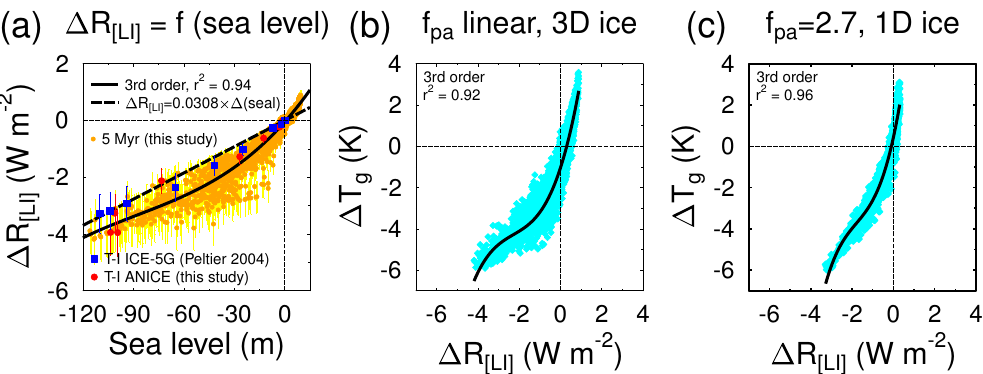
Figure 6. Details on land ice albedo forcing ( (cid:49)R [LI] ). Panel (a) : scatter plot of sea level change (de Boer et al., 2014) against land ice albedo forcing (this study), (cid:49)R [LI] , based on the 3-D ice-sheet model ANICE. Data are approximated with a third-order non-linear fit. For comparison, a fit based on sea level change as applied in other applications (Hansen et al., 2008; Martínez-Botí et al., 2015) is shown as dashed line. Furthermore, for Termination I (T-I), results based on ANICE and on ICE-5G (Peltier, 2004) are compared. Panels (b,c) : relationship between global surface temperature change, (cid:49)T g , and land ice albedo forcing, (cid:49)R [LI] , for different set-ups. Results plotted over the whole last 5Myr (one data point every 2kyr). Panel (b) : standard set-up with (cid:49)T g = (cid:49)T g1 = (cid:49)T NH · f − 1 pa using a polar amplification, f pa , that varies linearly as a function of (cid:49)T NH . (cid:49)R [LI] as based on 3-D ice-sheet models as calculated in this study (see Fig. 1c). Panel (c) : set-up with a constant f pa = 2 . 7 as applied previously in van de Wal et al. (2011). (cid:49)R [LI] is based on 1-D ice-sheet model results and is calculated from sea level change with 0 . 0308Wm − 2 per metre of sea level change. Underlying 1-D ice-sheet model results of (cid:49)T NH and sea level have been published previously (de Boer et al., 2010) and used elsewhere (Martínez-Botí et al.,